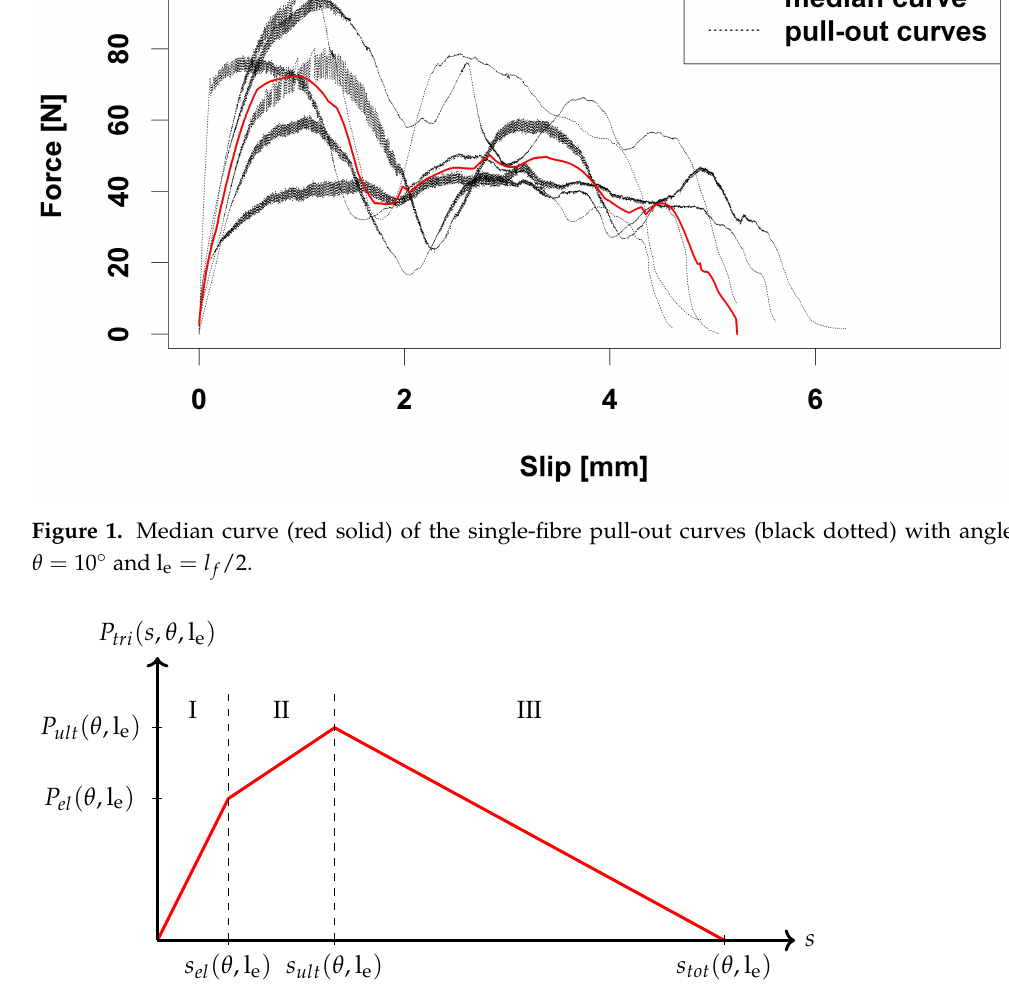
Figure 2. Simplified single-fibre pull-out curve. Phase I and II given as linear increasing branches and phase III given as linear descending